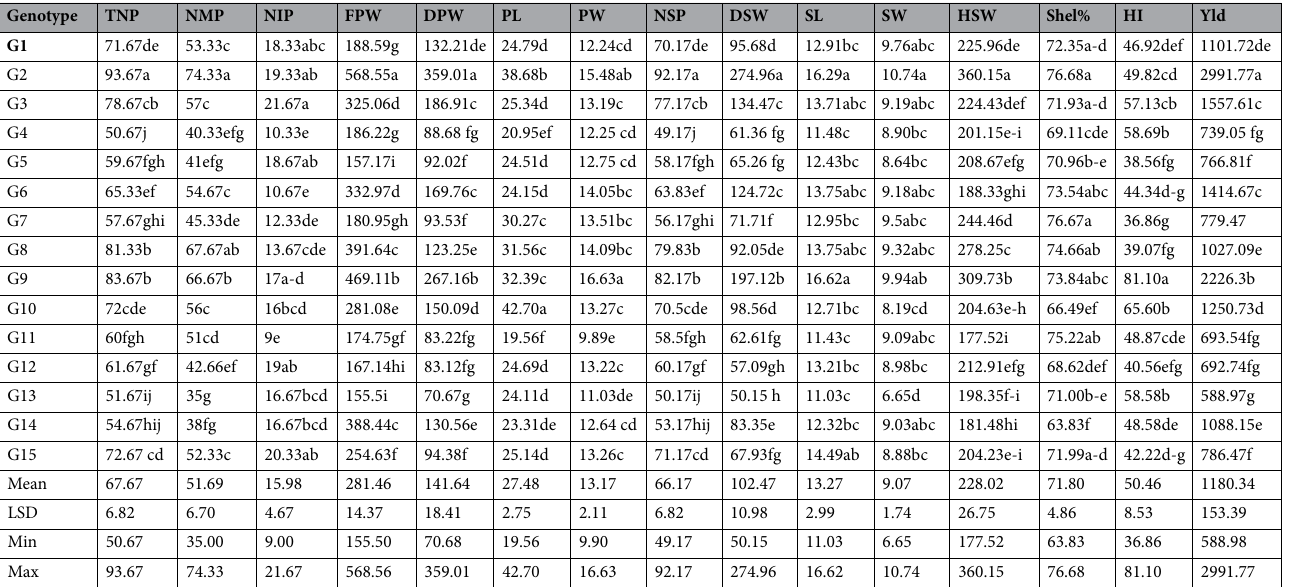
Table 5. The mean and mean comparison of 15 yield related traits of 15 Bambara groundnut accessions. Max maximum, Min minimum, C.V. coefficient of variation, LSD least significant difference at 5% level,